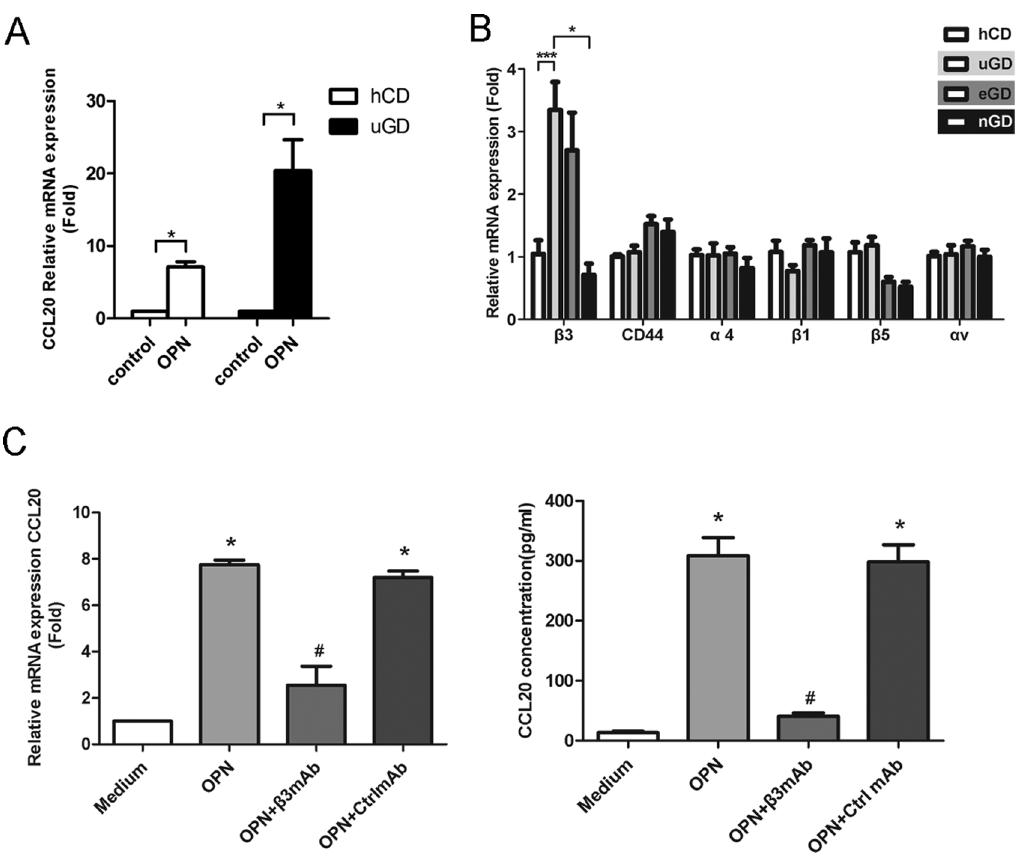
Figure 4. b 3 integrin receptor medicated OPN induction of CCL20 expressions. (A) CCL20 gene expressions in isolated CD4 + T cells from 8 hCD and 8 uGD in the presence or absence of 1 m g/ml rOPN for 12 h. (B) Expressions of OPN receptors on CD4 + T cells from uGD patients, eGD patients, nGD patients and hCD. (C) b 3 integrin receptor antibody blocked induction of CCL20 mRNA and protein levels by OPN. The freshly isolated PBMCs were cultured in the presence or absence of 1 m g/ml rOPN for 12 h. Blocking Abs to integrin b 3, or its isotype control mAb (IgG) were added at 5 m g/ml. Supernatants from cultures and CD4 + T cells separated from PBMCs were used to analyze the expression levels of CCL20. Shown are representative results from 3 independent experiments with separate specimens. All data were presented as mean 6 SEM. *, P , 0.05; ***, P , 0.001, versus medium control; # , P , 0.05 versus Ctrl mAb.